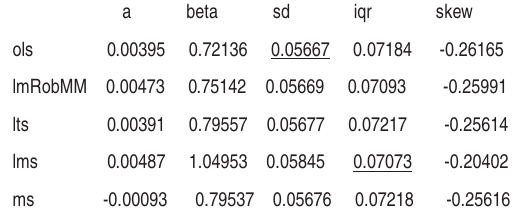
Table 2. Beta equations, residual standard devia- tions and interquartile ranges for BMY